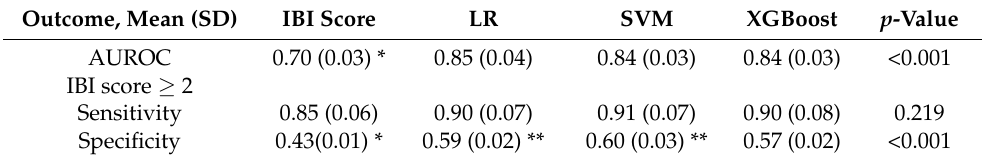
Table 5. ANOVA analysis of outcome prediction using the IBI score and developed ML models. Outcome, Mean (SD)